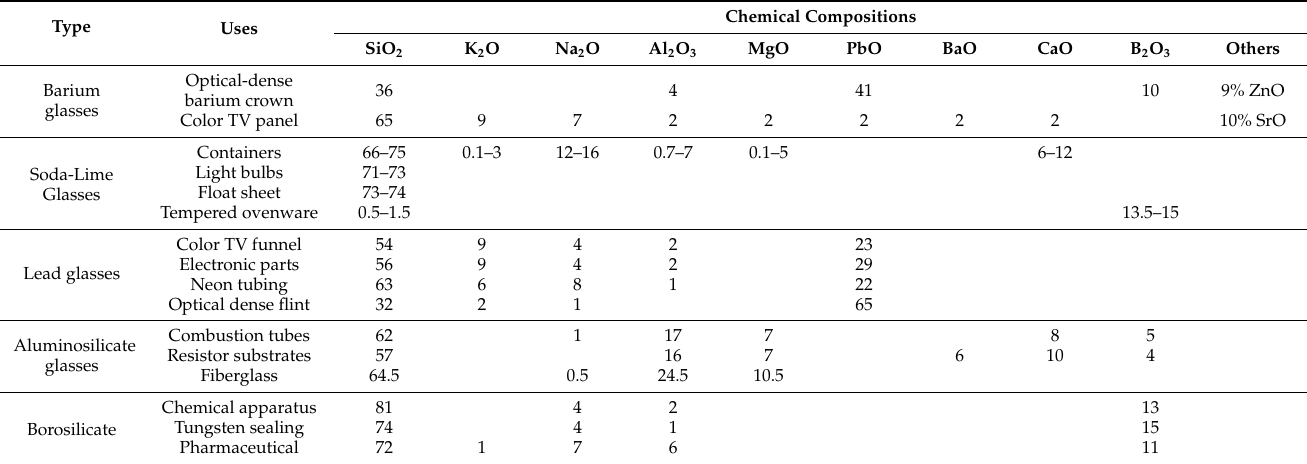
Table 2. Chemical components of glass for various types. Adapted from [38,39].